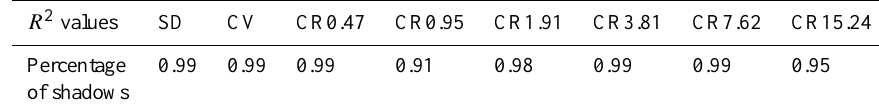
Fig. 6. The CR, Chain Roughness, obtained by the chain set method in the laboratory as a function of the diameter of the hemispheres and link length. Table 2. R 2 values of indexes for laboratory hemispheres. Results are obtained from regressions between percentage of shadows and the micro relief statistical indexes, CV and SD, and a single chain set, expressed as chain roughness (CR). R 2 values